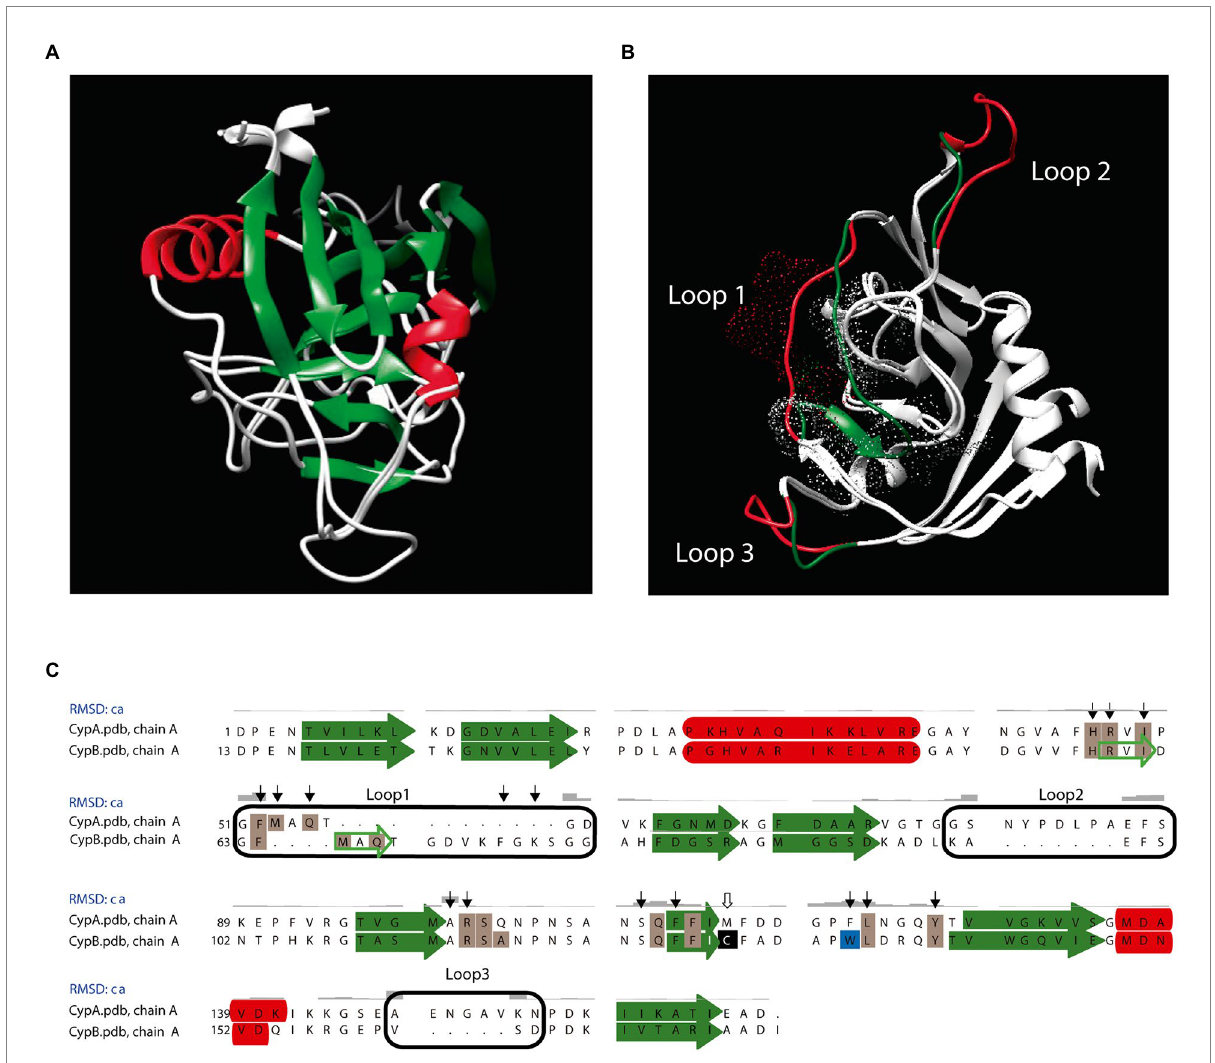
FIGURE 1 Comparison of the three-dimensional structural model of Brucella abortus cyclophilins. (A) Comparison of the three-dimensional structural model for B. abortus cyclophilins CypA and CypB. Swiss-model and Chimera 1.14 programs were used for the model and to compare three- dimensional structural, respectively. The Swiss-model program selected the structure of AquaCyp293 (PDB ID: 5ex2.1A) as a template for CypA and CypB. The predicted general protein structure consists of eight antiparallel beta sheets (green) and two alpha-helices (red). (B) Differential loops detected between CypA and CypB were indicated in red and green, respectively. Dot clouds highlighted the PPIase active site areas (C) Sequence alignment of B. abortus cyclophilins. Amino acid residues involved in cyclosporin (CsA) binding are indicated by black arrows, and those involved in peptidyl-prolyl cis / trans isomerase (PPIase) activity are highlighted in gray. Cysteine is indicated by a white arrow and highlighted in black and conserved tryptophan is highlighted in light blue. Secondary structures are indicated in green arrows (beta sheets) and red boxes (alpha-helices). Differential peptide loops are marked with black boxes. The alignment was performed with the Chimera 1.4 program.